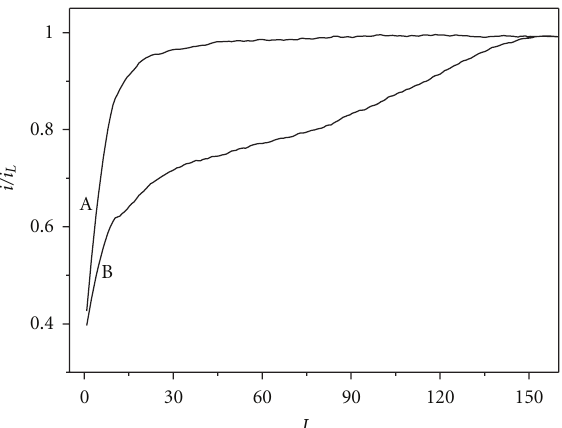
Figure 2: Approach curves obtained with a platinum microelec- trode ( r = 12 . 5 µ m) in a 0.2 mmolL − 1 H 2 SO 4 + 0.1molL − 1 KCl solution (pH = 3.4) for an insulating substrate (A) and a teeth sample (B), L = ratio between tip-substrate distance and microelectrode radius. Scan rate = 10 µ ms − 1 .